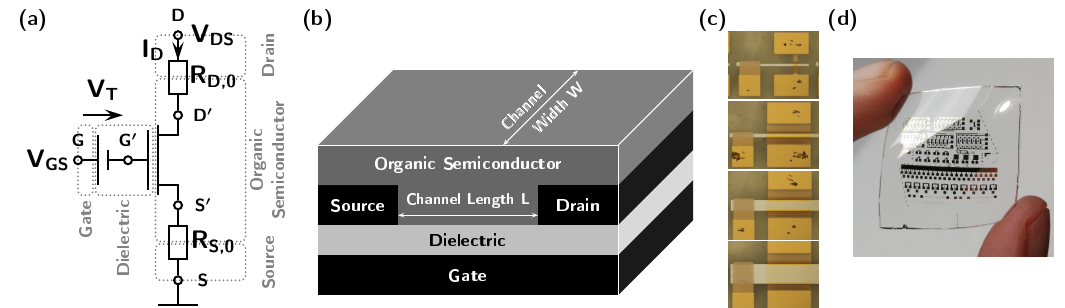
Figure 1. Panel ( a ) shows the equivalent circuit model based on an ideal field-effect transistor in the gradual channel approximation with a field- and charge-carrier-density-dependent mobility connected to the Ohmic source and drain resistances R S ,0 and R D ,0 . The threshold voltage V T is implemented in the form of an external bias. The terminals of the ideal transistor are labeled source S’ , drain D’ , and gate G’ , and the experimentally-accessible terminals are labeled source S , drain D , and gate G . The corresponding location of the elements in a real device is indicated in gray. In ( b ), a schematic drawing of a bottom-gate, bottom-contact thin-film transistor (TFT) is illustrated. In ( c ), optical microscopy images of bottom-gate, bottom-contact dinaphtho[2,3-b:2 (cid:48) ,3 (cid:48) -f]thieno[3,2-b]thiophene (DNTT) TFTs with channel lengths of 2, 8, 40, and 80 µ m from top to bottom can be seen,